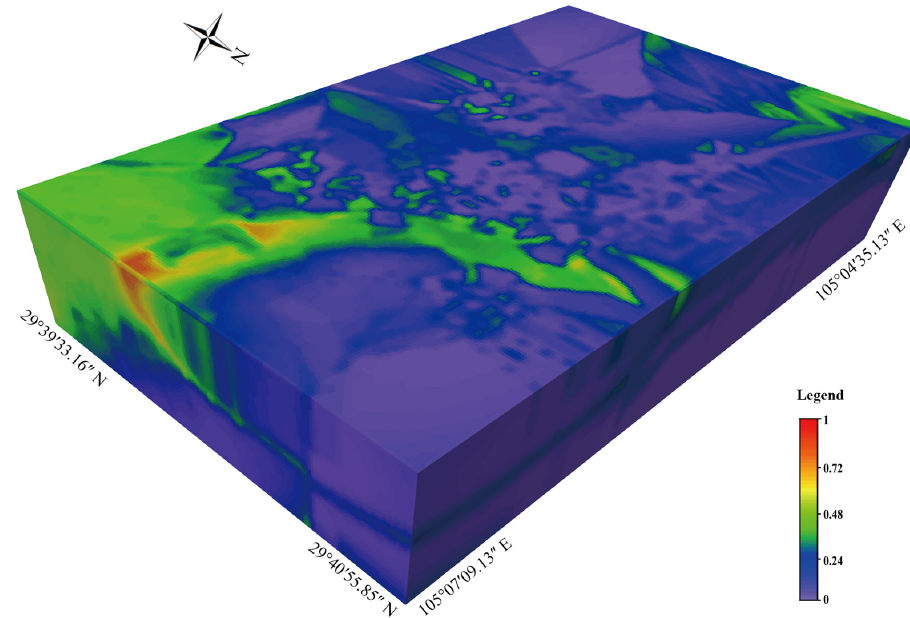
Figure 6. Uncertainty model of progressive modeling.